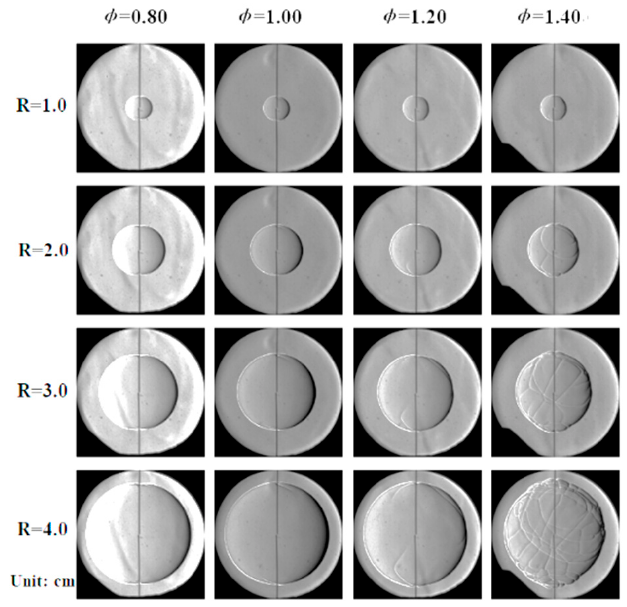
Figure 2. Typical schlieren images of the flame propagation process.